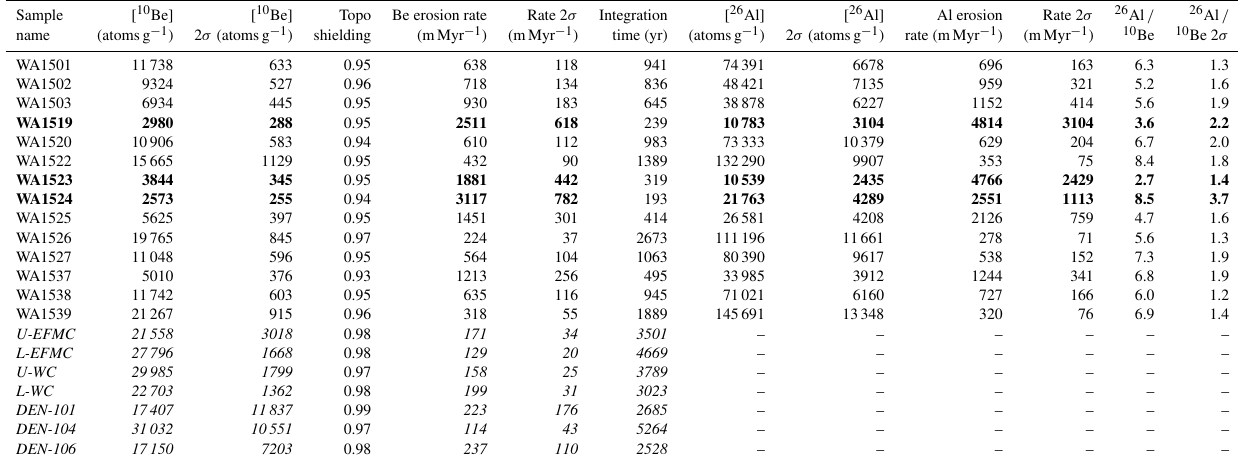
Table 3. Basin-averaged erosion rate sample data. Integration time was calculated by dividing the e -folding depth of the production of cosmic nuclides via spallation (0.6m) by the erosion rate. Italicized samples are from Belmont et al. (2007). Bold samples had 10 Be measurements less than 10 times the blank